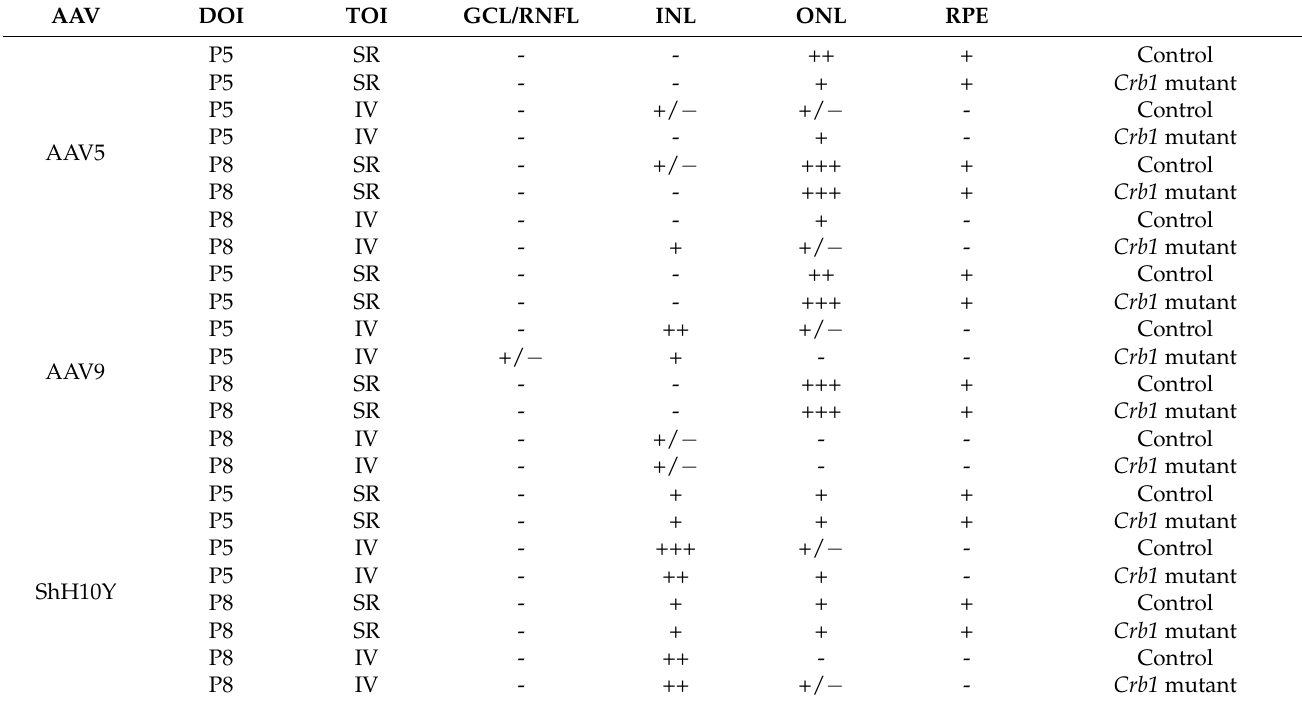
Table 1. Summary of the retinal tropism of three different adeno-associated viral vector (AAV) serotypes, namely, AAV5, AAV9 and ShH10Y, injected via two different routes of delivery at P5 or P8 in control and Crb1 mutant rat retina. For each serotype and route of delivery, a dose of ~1 × 10 13 gc/mL was injected in a volume of 1 µ L. Quantified data are presented as follows: no GFP positive (-); 1 GFP positive (+/ − ); 2–5 GFP positive (+); 6–10 GFP positive (++); 11–15 GFP positive (+++); and ≥ 16 GFP positive cells (++++) per 100 µ m. Number of animals analyzed: AAV5 control P5 SR n = 6, P5 IV n =